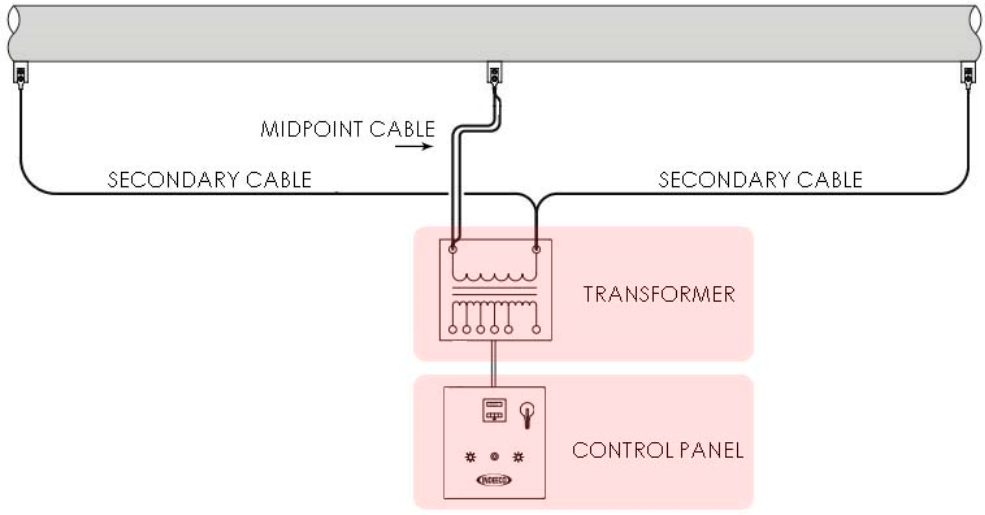
Figure 7. Mid-point electrical connection (Adapted from [27]).